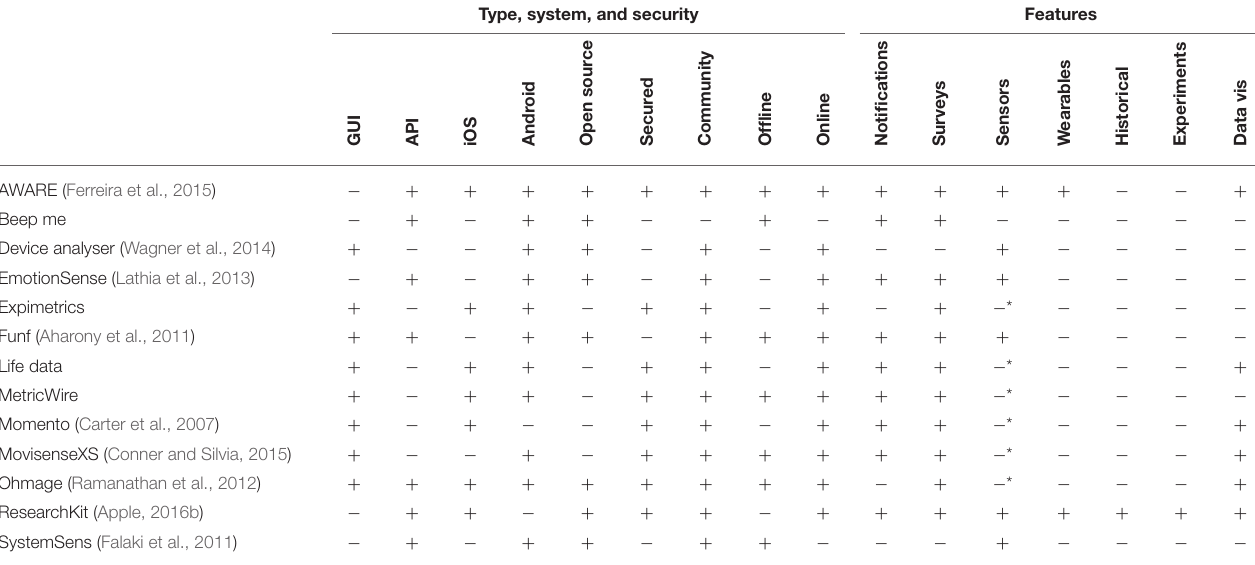
TABLE 1 | A comparison of frameworks and solutions that have been developed to facilitate the process of creating apps for research